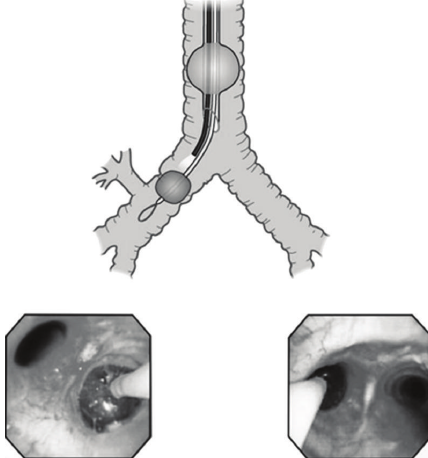
Figure 2: The proper position of a bronchial blocker seen with fiberoptic